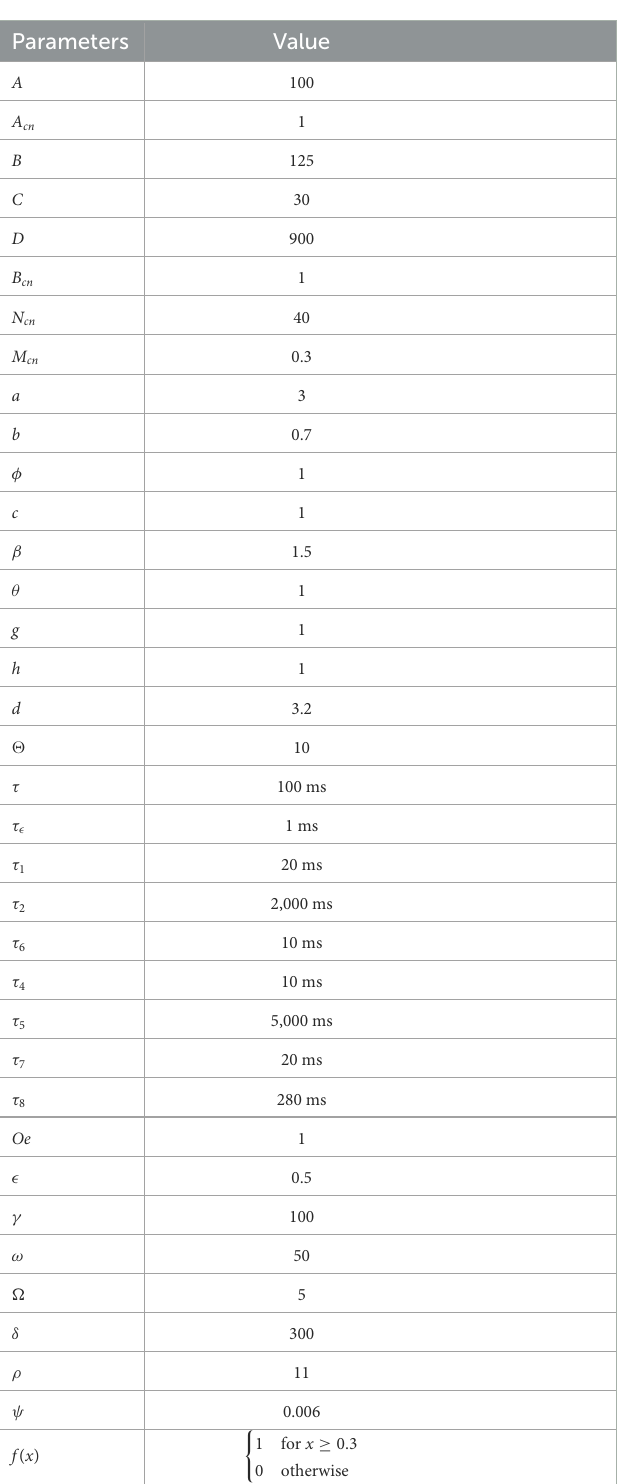
inhibitory projections.